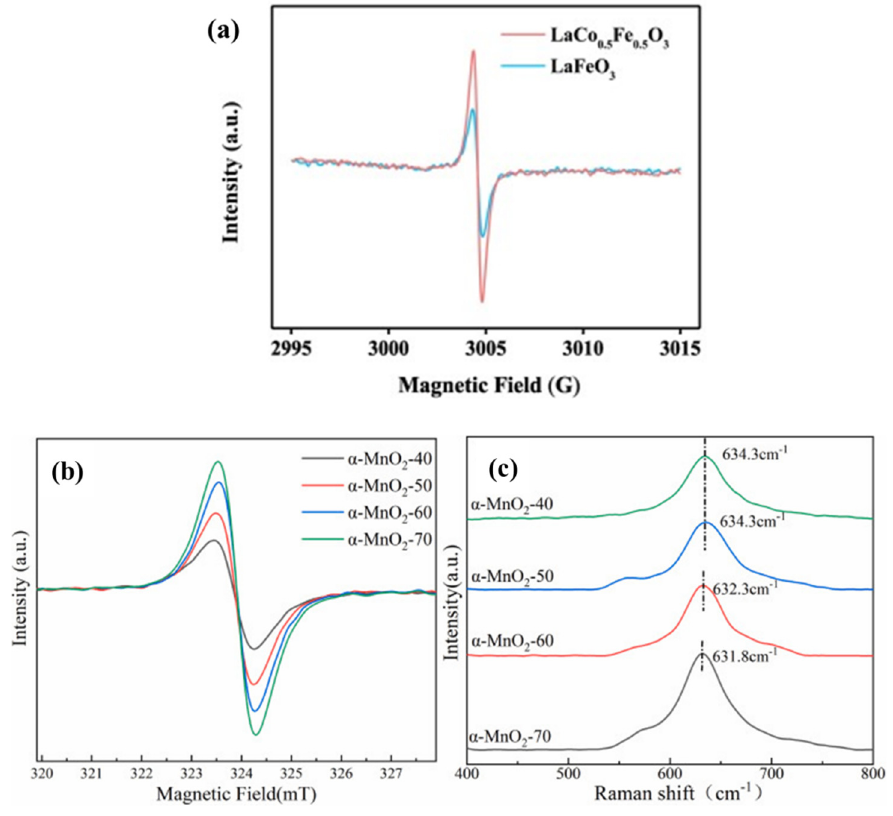
Figure 5. ( a ) LaCo 0.5 Fe 0.5 O 3 in LaCo 0.5 Fe 0.5 O 3 /PMS system and ESR spectra representing oxygen va- cancies in LaFeO 3 and LaCo 0.5 Fe 0.5 O 3 and EPR ( b ) and Raman ( c ) profiles of different catalysts [98 −